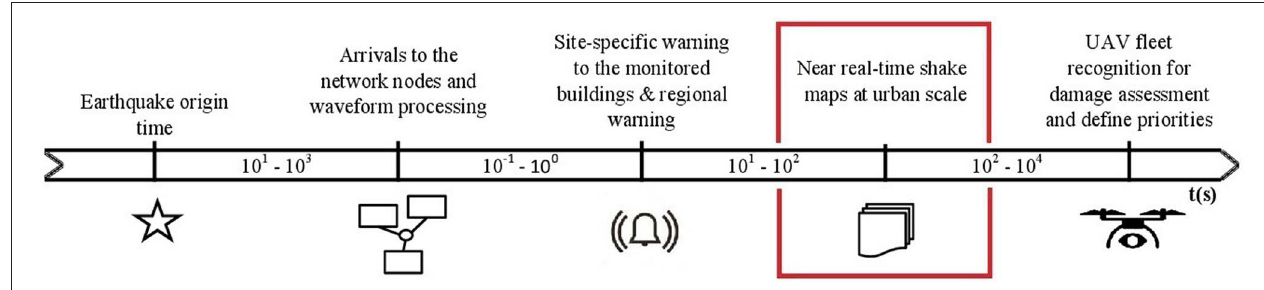
FIGURE 5 | General scheme and time progress bar (in seconds) of all the potential tasks of an urban seismic network; the post-earthquakes rapid disaster assessment task is highlighted in